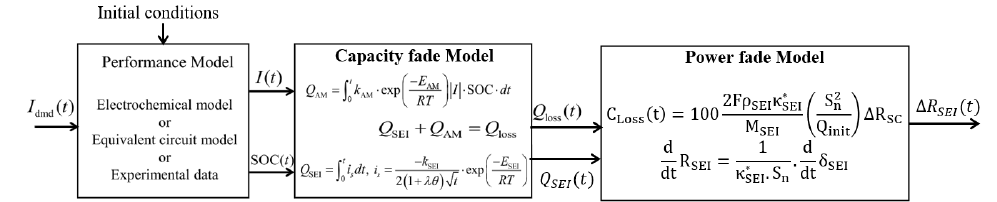
Figure 2. Structure of the physics-based